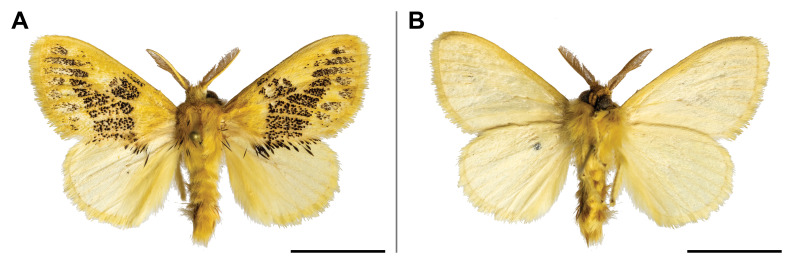
Euproctis
ceramozona Collenette, 1931. A. dorsal view; B. ventral view. The scale bar represents 1 cm.